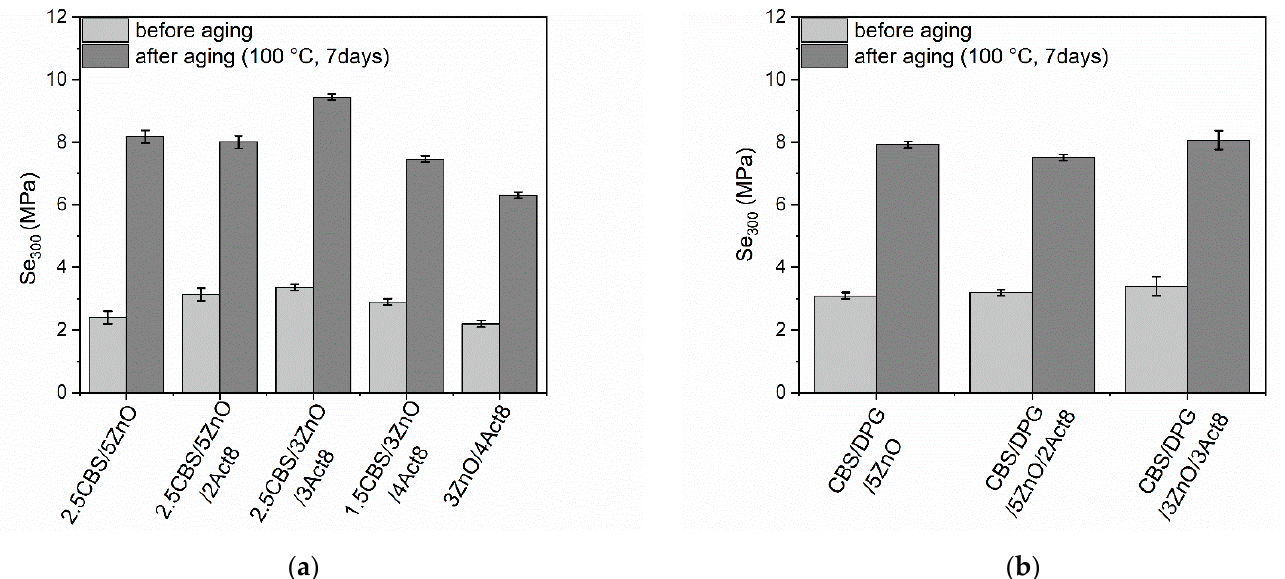
Figure 6. Influence of thermo-oxidative aging on the stress at 300% relative elongation (Se 300 ) of SBR vulcanizates containing: ( a ) CBS; ( b ) CBS and DPG.